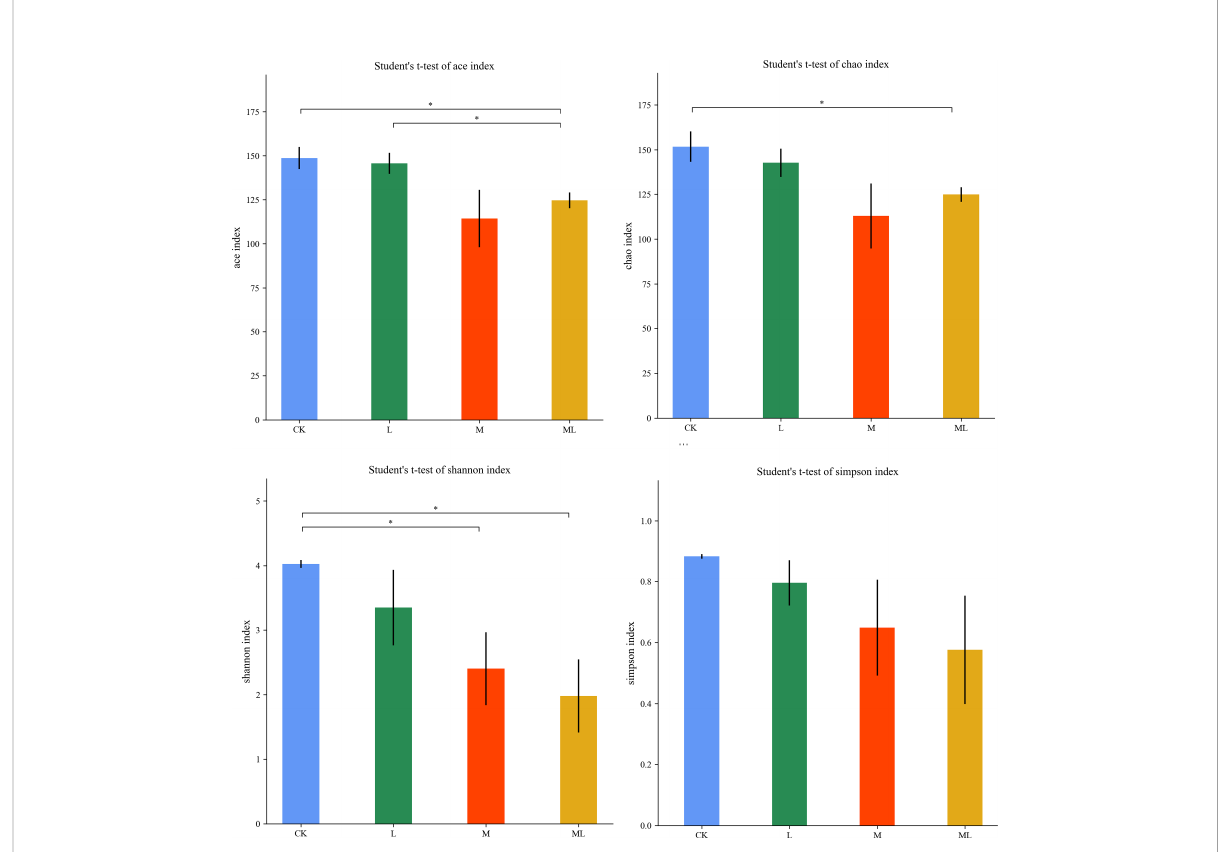
FIGURE 2 a -Diversity of bacterial diversity of mixed silage of KG and CF supplemented with L and M (CK, control; L, lactic acid bacteria; M, molasses; ML, lactic acid bacteria + molasses). *p <